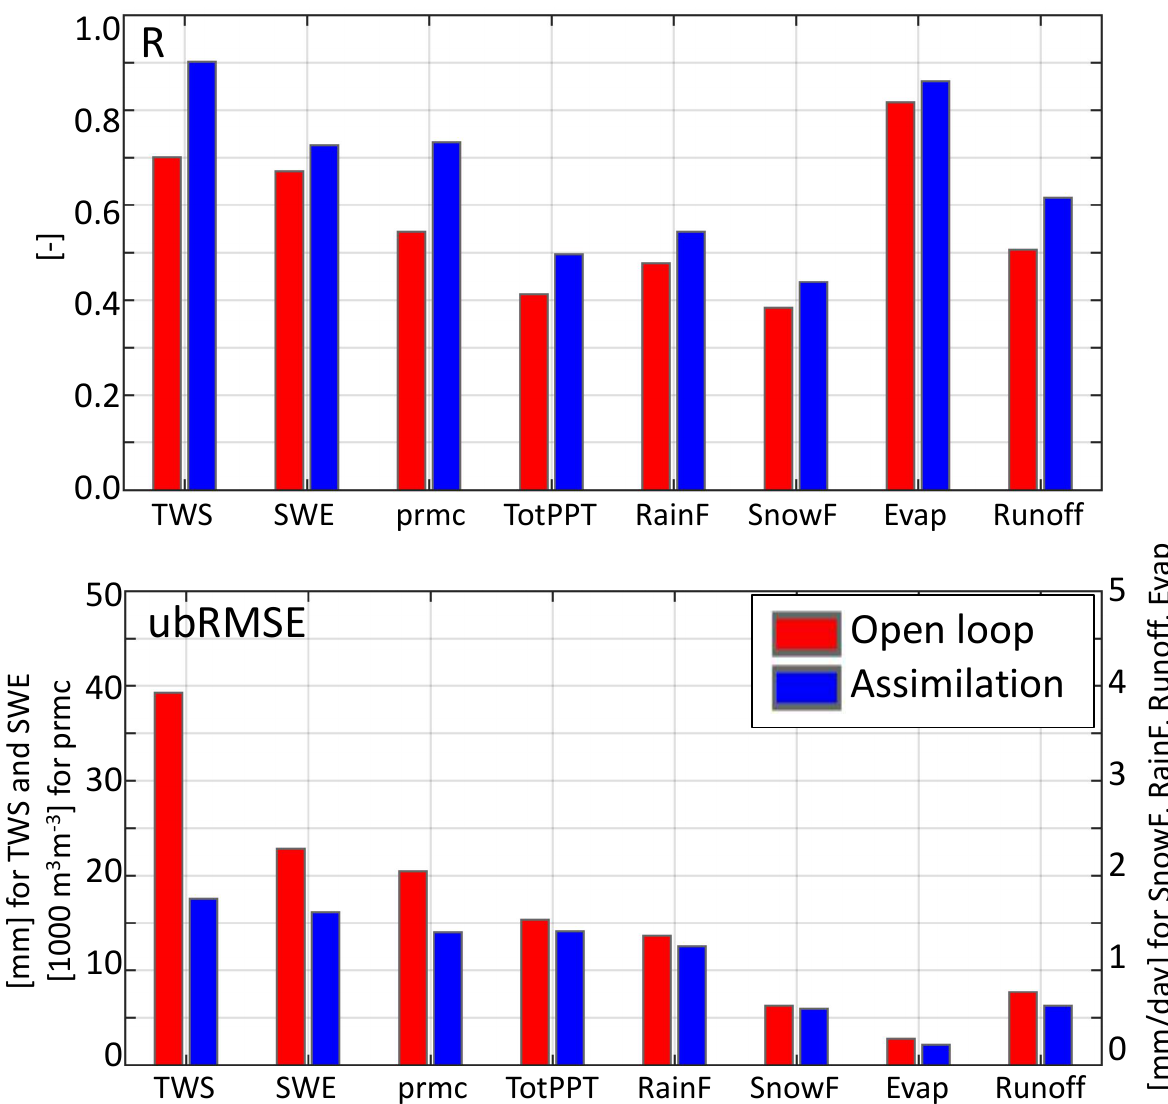
Figure 5. Domain-average skill metrics for the assimilation (blue) and open-loop (red) experiments for TWS, snow water equivalent (SWE), snowfall (SnowF), rainfall (RainF), total precipitation (TotPPT), profile soil moisture (prmc), runoff and evaporation (Evap). Skill is measured in terms of time series ( a ) correlation ( R ) and ( b ) unbiased root mean square error ( ubRMSE ) vs. the synthetic true values. The assimilation skill for all variables (including precipitation fluxes) are improved compared to the